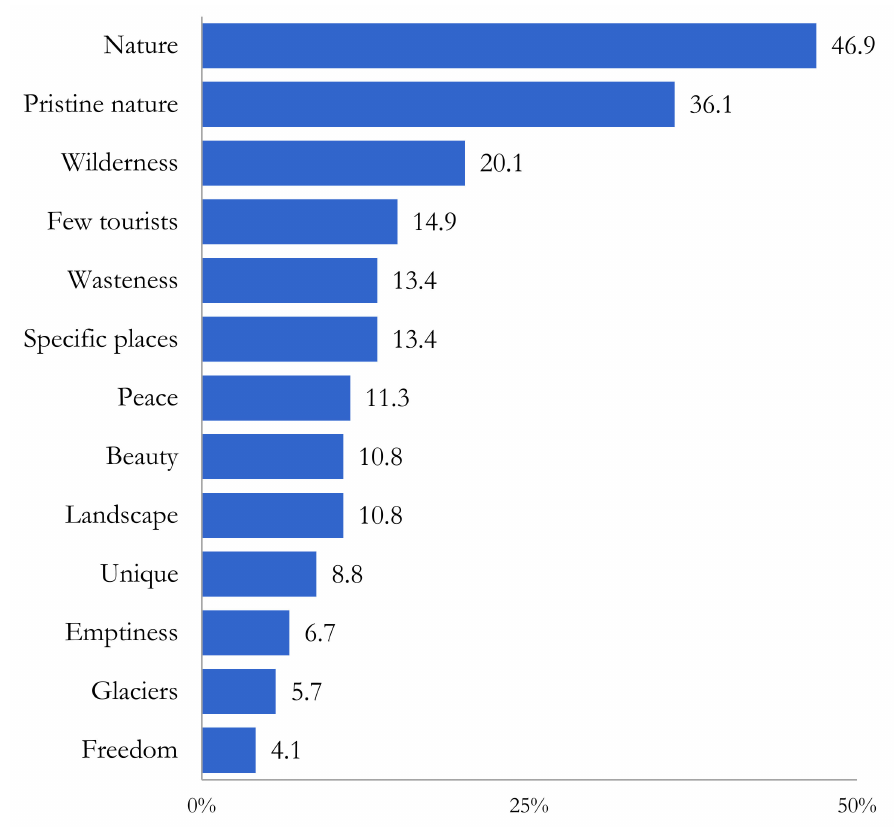
Figure 3. The Icelandic Central Highlands’ attraction as evaluated by the tourism